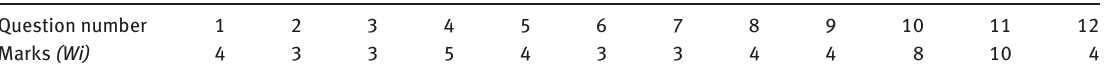
Table 3: Weightage of Each Question.